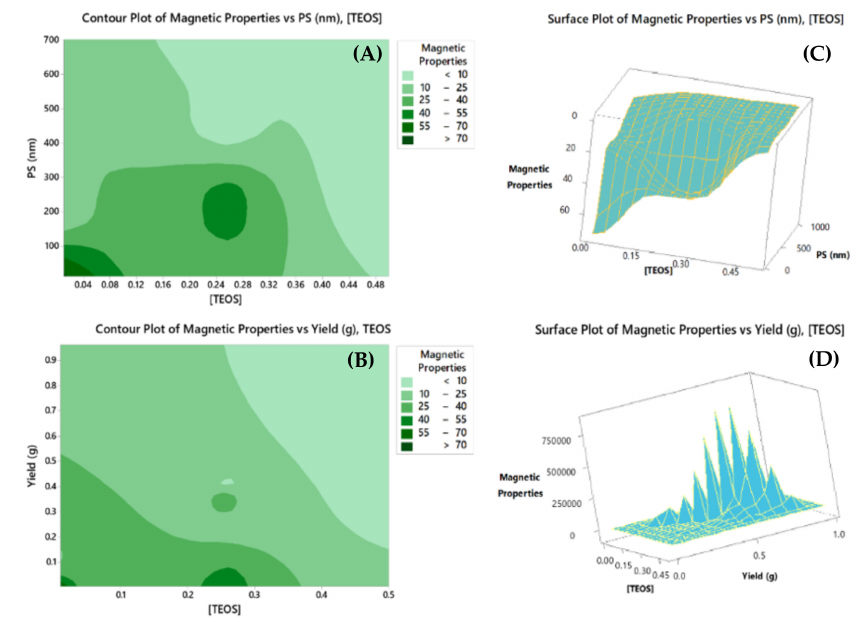
Figure 3. Contour to study the variation in magnetic properties (z-axis) as a function of particle size (PS) (nm) and [TEOS], and yield (g) and [TEOS]. Magnetic property is considered the response variable while [TEOS], PS (nm), and yield (g) are the predictors. Figures shown are the contour plot of magnetic properties vs. ( A ) PS (nm) and [TEOS]; ( B ) Yield (g) and [TEOS] and surface plot of magnetic properties vs. ( C ) PS (nm) and [TEOS]; ( D ) Yield (g) and